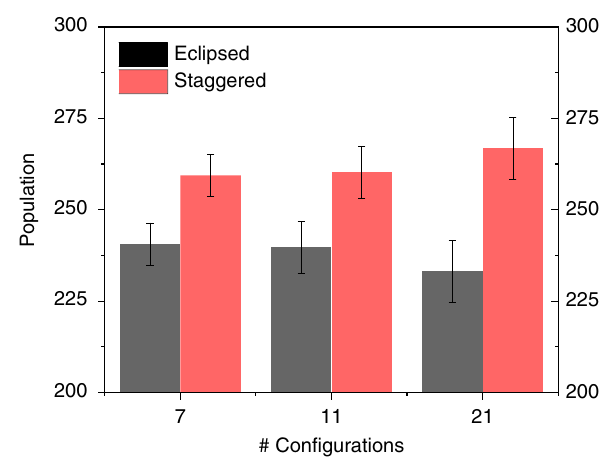
Fig. 4 The equilibrium populations of eclipsed and staggered Kekulé structures (2 σ error). As the number of con fi gurations contributing to the wavefunction is increased, there emerges a distinct preference for the staggered Kekulé structures over the eclipsed Kekulé structures.